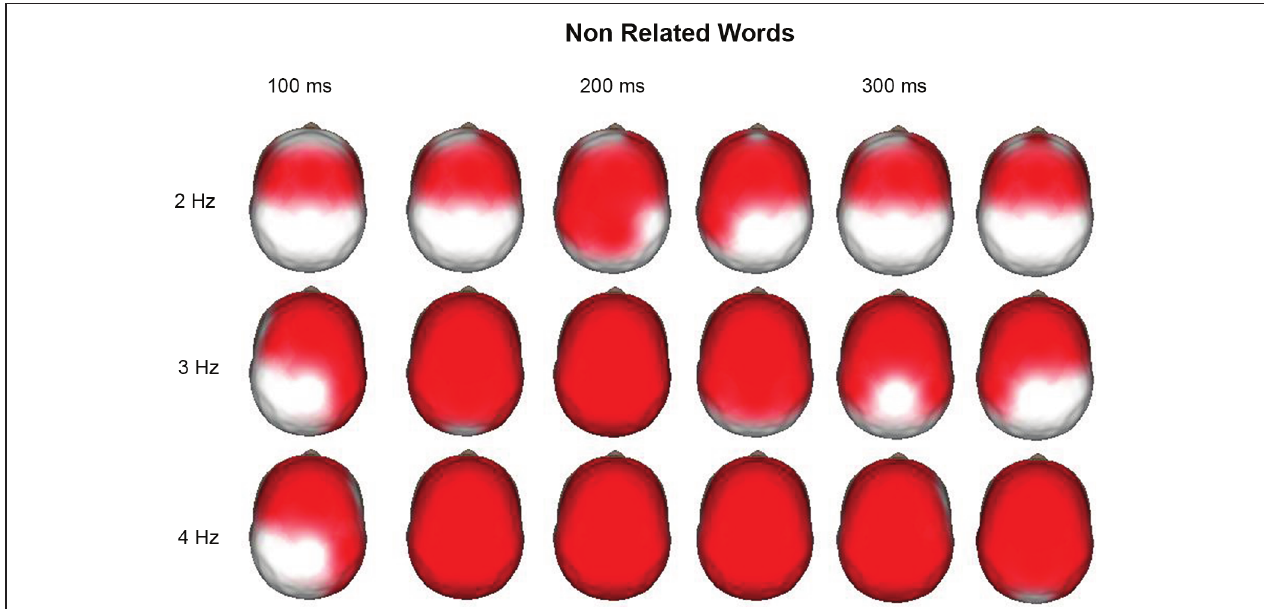
350 ms. At 2 Hz the main increases across time are observed in the anterior regions, as well as for 3 and 4 Hz at 100 ms. In these two last frequencies the increase is generalized to all the surface